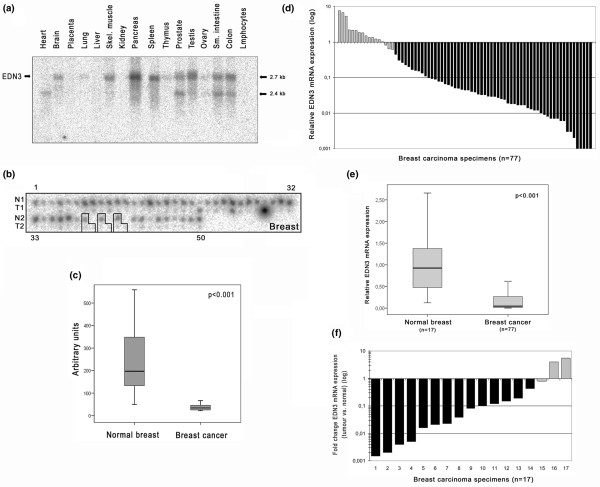
Differential expression of EDN3 mRNA in human breast cancer. (a) A multiple tissue Northern blot hybridised with an EDN3-specific probe indicates ubiquitous expression of EDN3 mRNA in a variety of normal tissue types. In some tissues, both major EDN3 transcript variants are expressed (2.4 and 2.7 kb). (b) The same probe was hybridised to a breast cancer array containing cDNA pairs from 50 breast carcinoma tissues (T), 50 matched normal breast tissues (N) and 3 metastatic tissues. The outlined groups represent matched pairs, including the metastatic deposit, and consecutive numbers indicate specimen spots on the array. (c) Box plot demonstrating significant downregulation of EDN3 expression between normal and tumourous breast tissues (P < 0.001, Student paired t test; extreme value of specimen #29 omitted). Horizontal lines indicate group medians, and boxes indicate 25% to 75% quartiles, range, peak and minimum. (d) Real-time polymerase chain reaction analysis demonstrated loss of EDN3 expression in 78% of breast carcinomas by FC2 (fold change of greater than 2) (black bars) whilst 22% showed no deregulation (grey bars). (e) Box plot demonstrating the different distributions of EDN3 expression among normal breast tissues and breast carcinomas (P < 0.001, Mann-Whitney U test). Horizontal lines indicate group medians, and boxes indicate 25% to 75% quartiles, range, peak and minimum. (f) Fold changes of EDN3 expression in 17 matched pairs of normal breast and breast carcinoma samples revealed loss of expression in 13 cases (76%) and a median expression change of 13-fold. EDN3, endothelin-3.